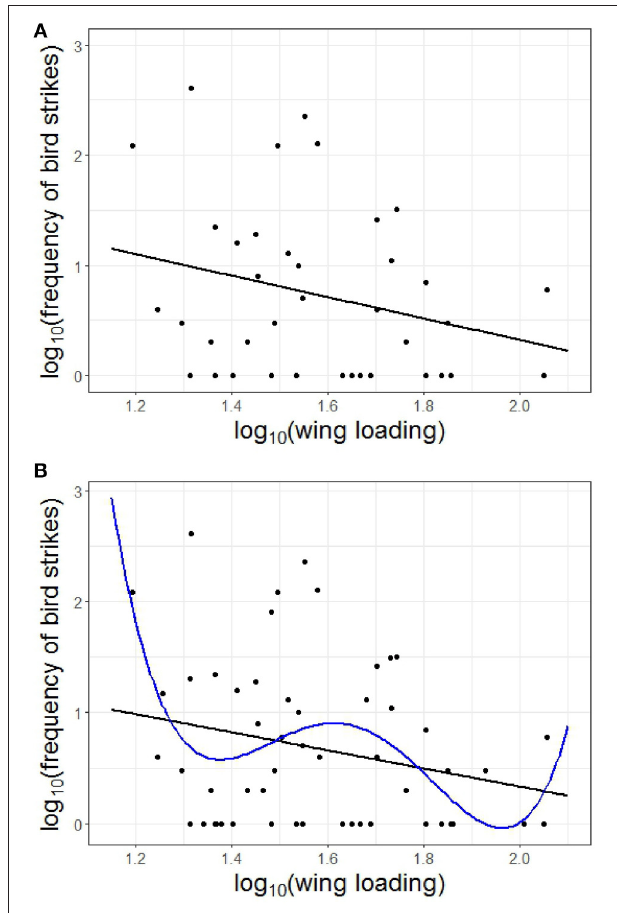
FIGURE 1 | Relationship between wing loading and the frequency of bird strikes based on (A) 38 bird species, and (B) 54 bird species controlling for the effects of phylogenetic relatedness. Shown in (B) are two models that significantly fit the data: linear in black (y = ax + b) and polynomial of order 4 in blue (y = ax 4 + bx 3 + cx 2 + dx + e). See text for